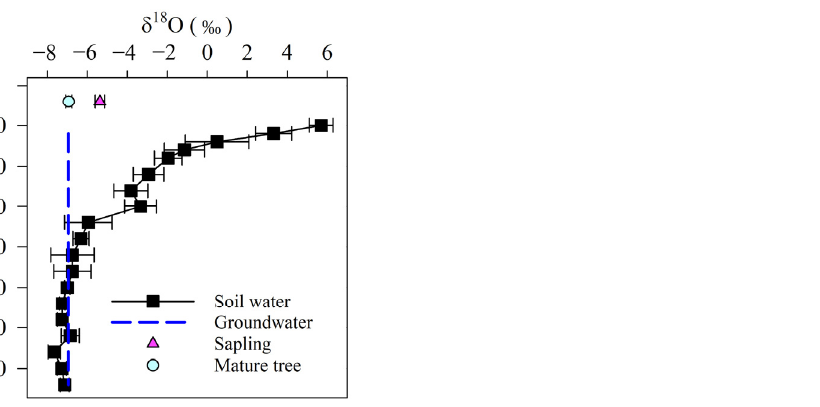
Figure 2. Stable oxygen isotopic signature of plant xylem water, soil water, and groundwater.